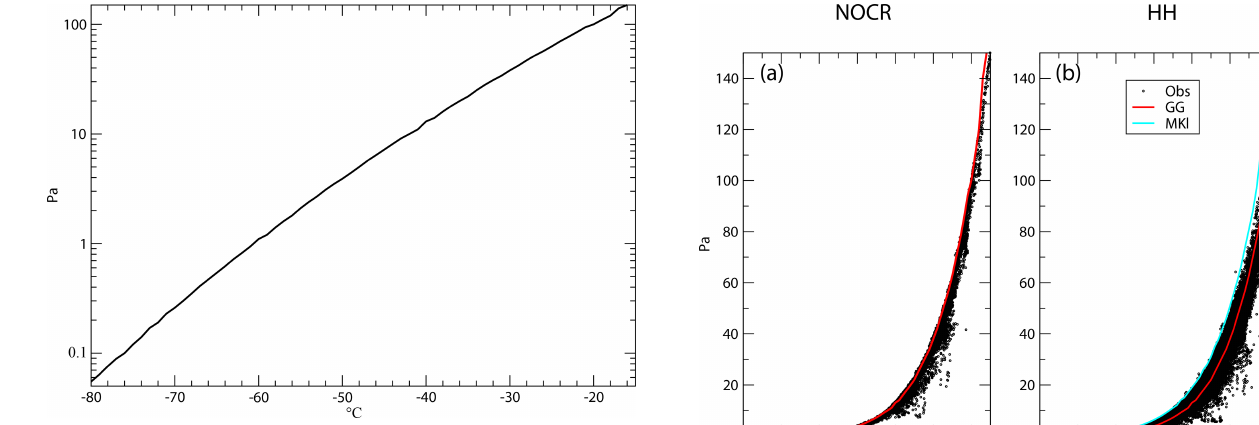
Figure 2. Calculated saturation pressure vapor (in Pa) with respect to ice as a function of temperature in the range occurring in the sur- face atmosphere at Dome C, using the Goff and Gratch (1946) ap- proximation of the Clausius–Clapeyron equilibrium. Note the loga- rithmic y axis.